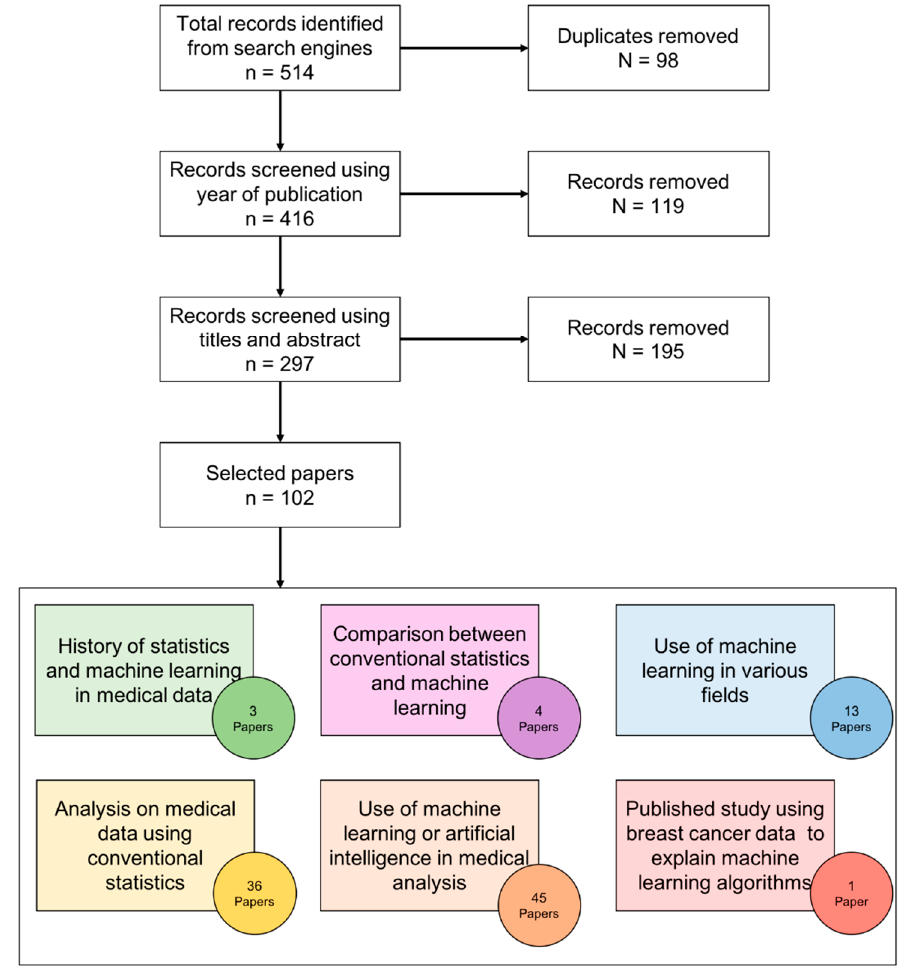
Figure 2. Survey methodology for literature selection.